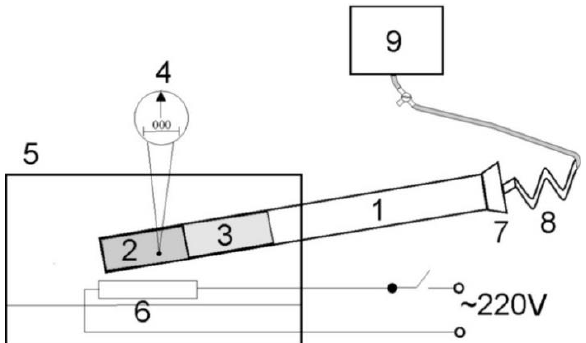
Figure 1. Schematic diagram of the installation for thermal decomposition of metal hydrides: (1) heating chamber, (2) cartridge, (3) porous ceramic plug, (4) thermocouple, (5) muffle furnace, (6) heater, (7) rubber plug with a tube for gas extraction, (8) standard coil, and (9) measuring container for released gas.